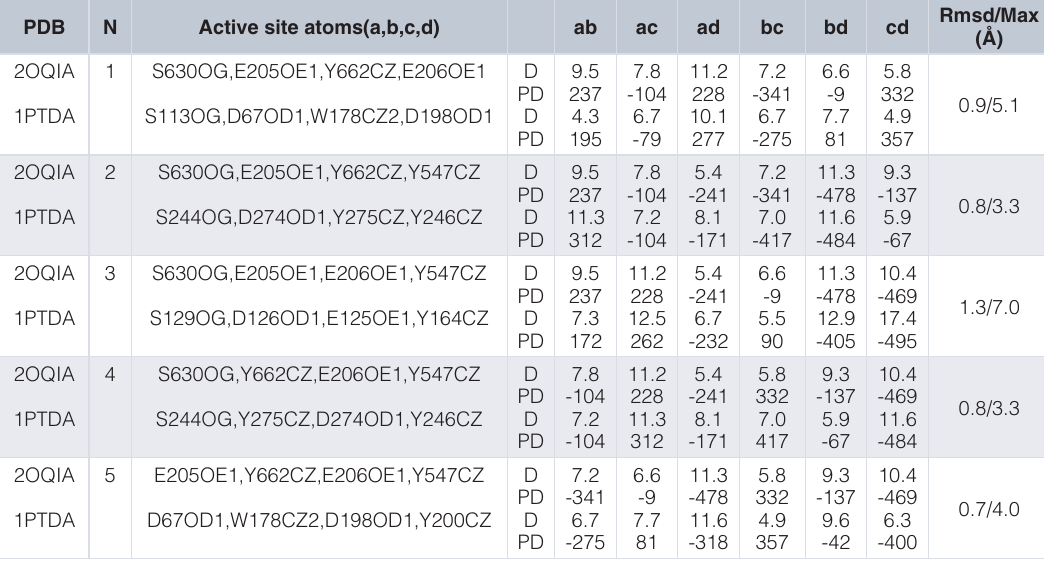
Table 3. Querying PI-PLC using partial motifs derived from the atoms in vildagliptin that make contact to the DPP4 enzyme (PDBid:3W2TA). The comparison is done using apo enzymes (PDBid:1PTDA for PI-PLC and PDBid:2OQIA for DPP4), since the binding of a ligand induces spatial and electrostatic changes in the active site. The fifth motif has the least rmsd deviation, and comprises of active site residues (involved in the binding of myo- inositol in PDBid:1PTGA). Out of the best matches in the other four motifs, three do not comprise of active site residues (motifs 2, 3 and 4). Motif 1 has a reasonably significant match, and has three residues (Asp67, Asp198 and Trp178) in common with the best match for Motif 5. These three residues from PI-PLC (Asp67, Asp198 and Trp178) and corresponding three residues from DPP4 (Glu205, Glu206 and Tyr662) were used to superimpose DPP4 and PI-PLC. N = Motif number. D = Pairwise distance in Å. PD = Pairwise potential difference. Rmsd = Root mean square deviation. Max = maximum pairwise distance deviation. APBS writes out the electrostatic potential in dimensionless units of kT/e where k is Boltzmann’s constant, T is the temperature in K and e is the charge of an electron. PDB